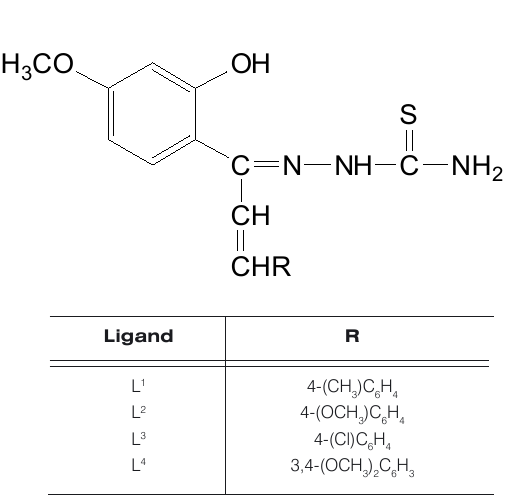
Figure 1. Structure of chalcone